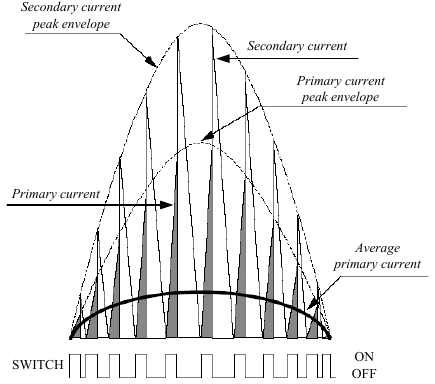
Figure 4. Current waveforms of the single-stage power factor (PF) flyback converter